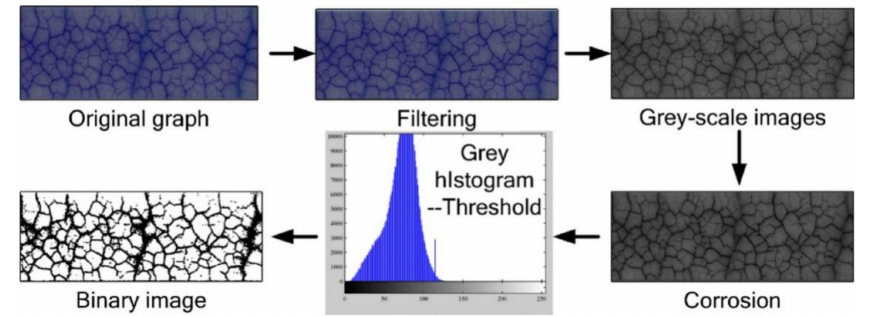
Figure 5. Image preprocessing method based on original crack